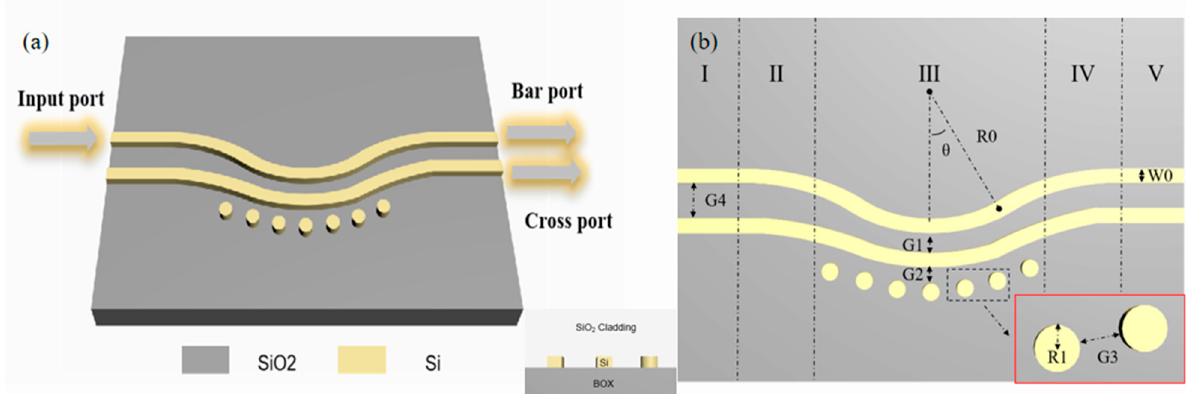
Figure 1. ( a ) Schematic view of the proposed power splitter with a group of silicon columns introduced into the coupling region in standard silicon-on-insulator. ( b ) The top view of the schematic and the geometric parameters of the proposed 3-dB power spli tt er.